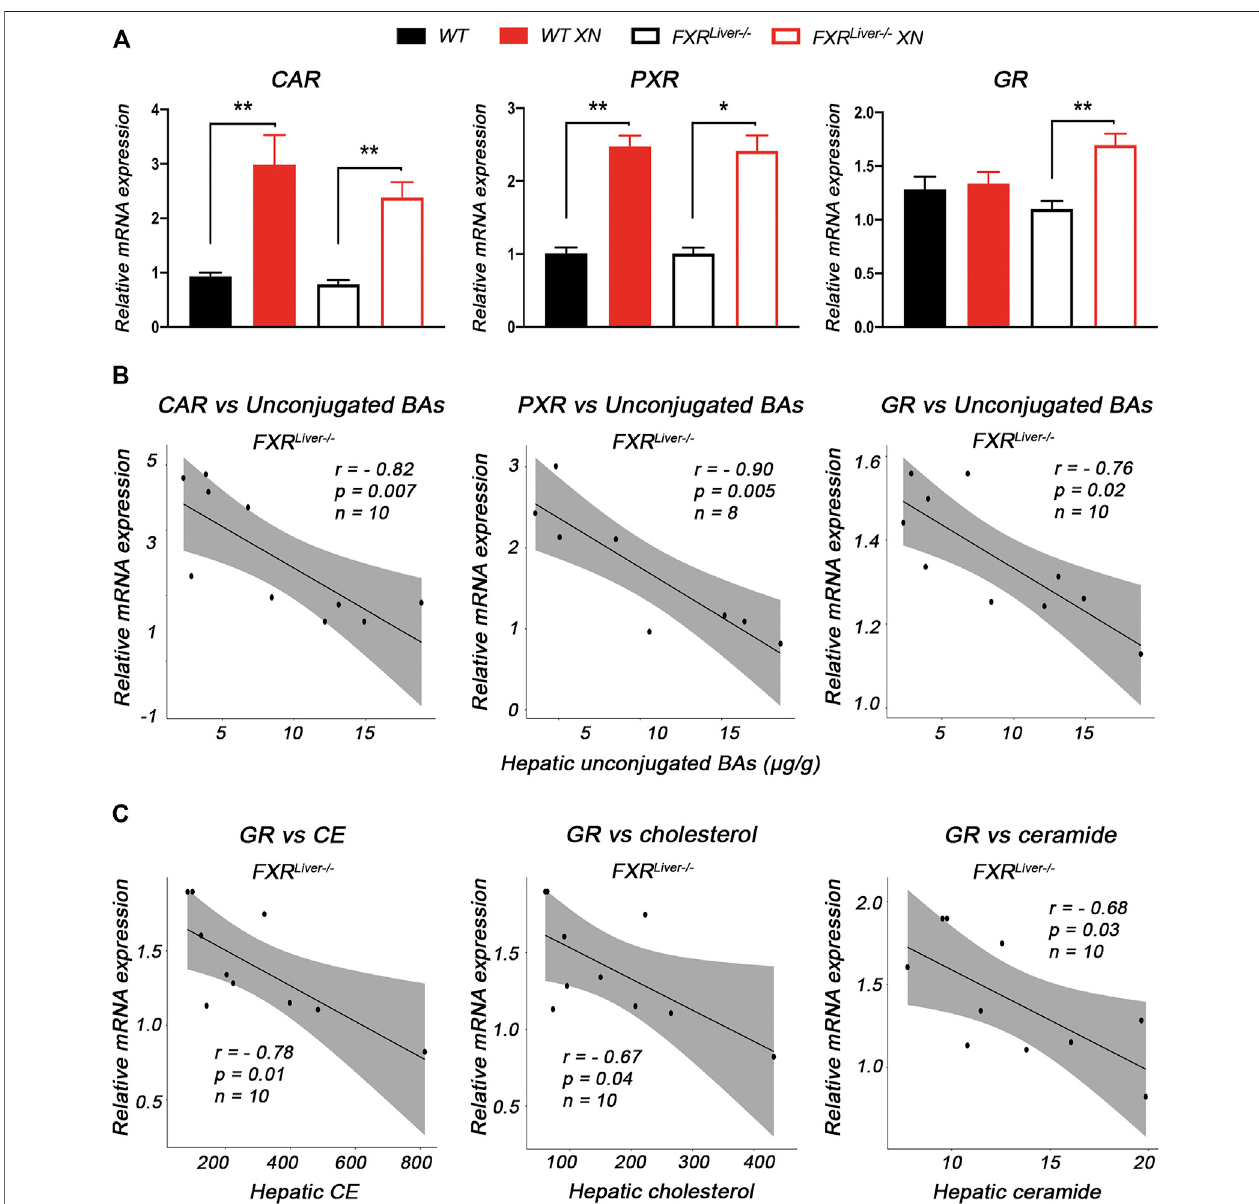
FIGURE 6 | XN induces hepatic expression of FXR-independent NRs (A) Quantitative relative expression of CAR, PXR and GR in the liver of HFD-fed WT and FXR Liver − / − mice (B) Correlations between relative mRNA expression of CAR, PXR and GR vs. hepatic unconjugated BAs concentrations in FXR Liver − / − mice (C) CorrelationsbetweenrelativemRNAexpressionofGRvs.relativeabundancesofhepaticCE,cholesterolandceramideinFXR Liver − / − mice.Bargraphsvaluesaremean ± SEM, n (cid:2) 4-5 mice (males and females) per group. * p < 0.05, ** p < 0.01, *** p < 0.001 for effect of XN treatment.